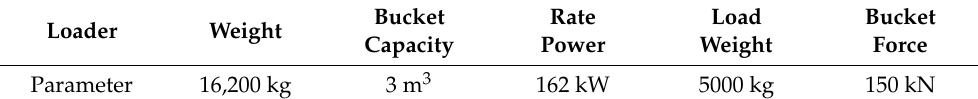
Table 1. Parameters of the 5-ton loader.